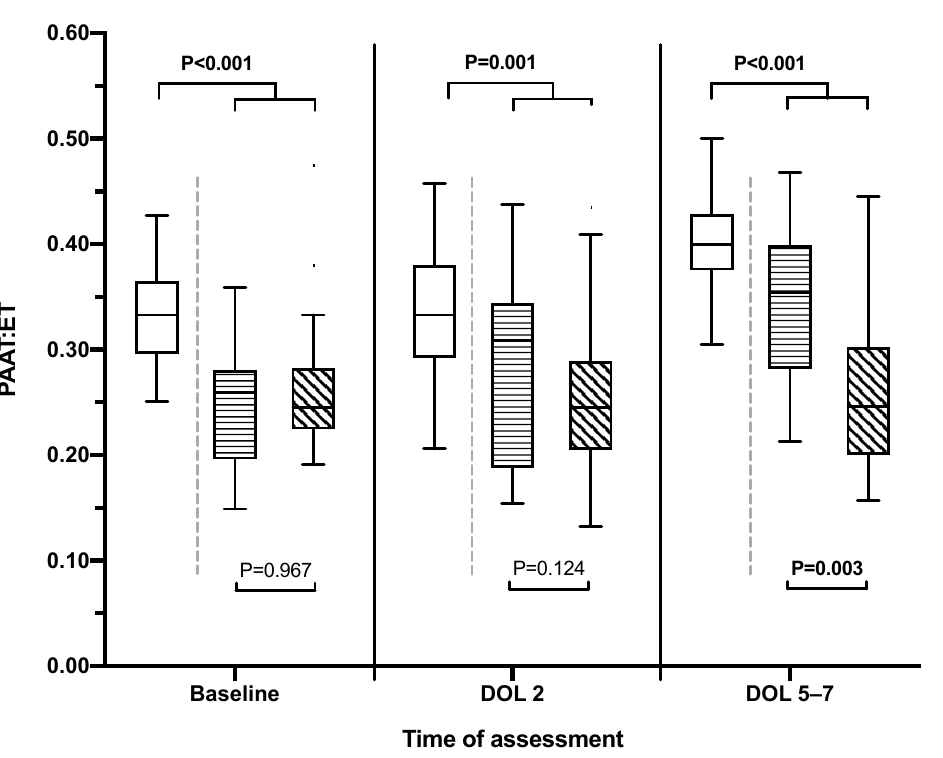
Figure 2. PH severity in the first week of life in ECMO and non-ECMO patients.